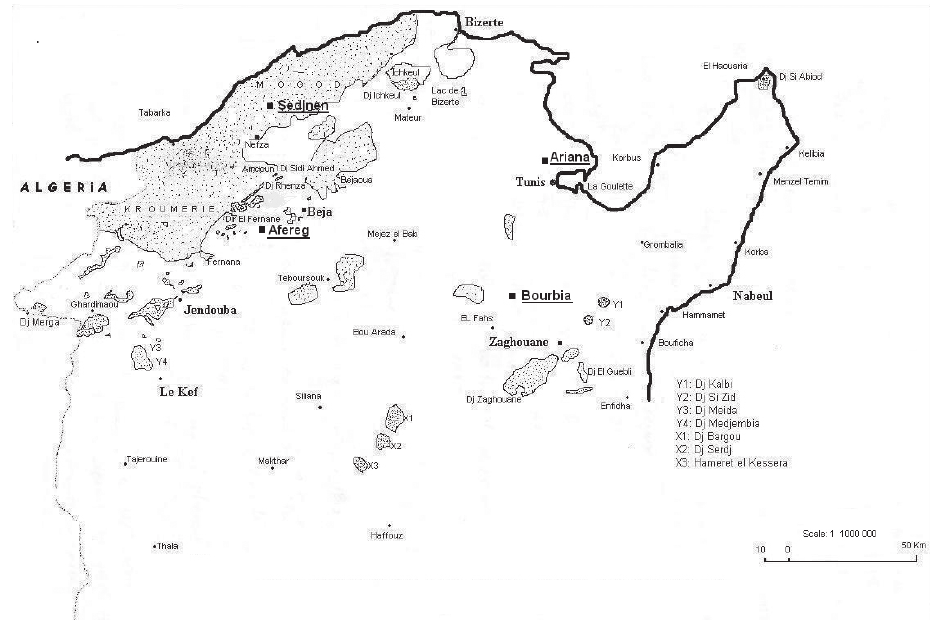
Figure 1. The four regions of Tunisia surveyed and the distribution of buckthorn, represented by dotted surfaces (Shonenberger and Gounot,